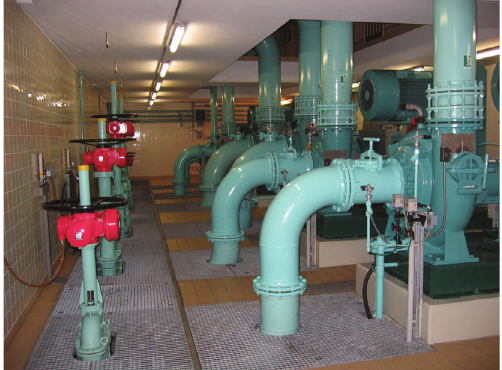
Figure 3: Closed test loop for centrifugal